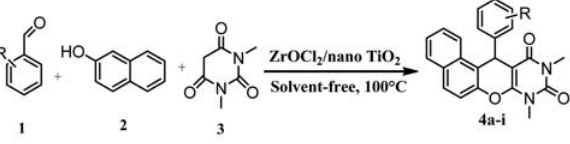
Figure 2 . SEM image of ZrOCl